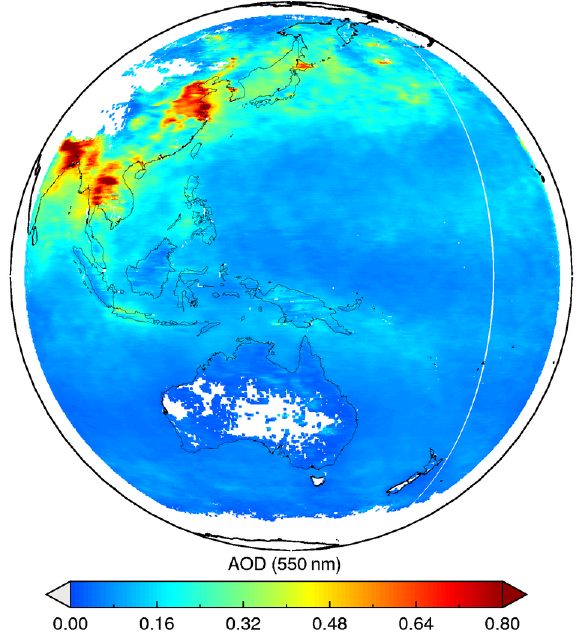
Figure 9. Daily mean AOD at 550nm calculated over all daylight full-disk images of AHI during May–June 2016. No requirements of collocation with MODIS or AERONET were imposed. Figure 10. Difference in hourly mean AOD at 550nm as derived from the new DT AHI algorithm from the daily mean AOD, as plot- ted in Fig. 8. Red indicates the specific hour has higher AOD than the daily mean, and blue indicates the